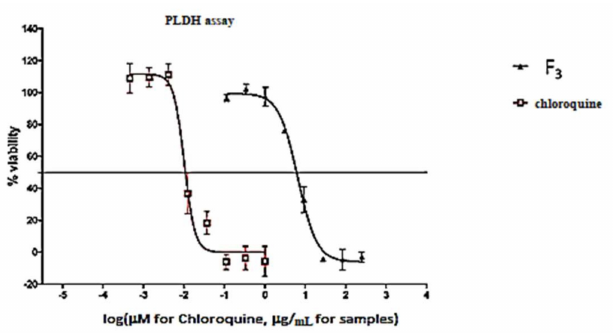
Figure 3. Dose-response curve for antimalarial